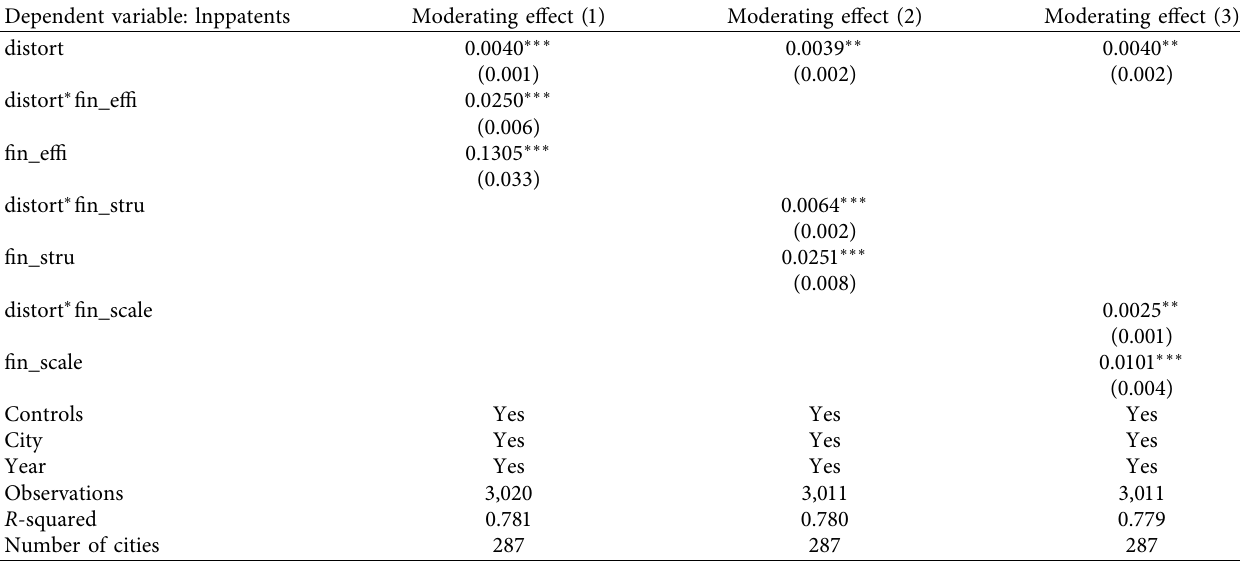
Table 3: Regression results of moderating effect of financial development